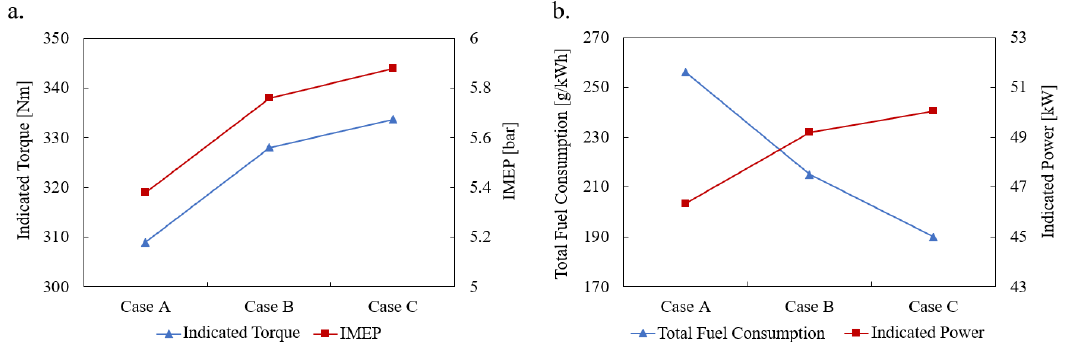
Figure 17. Comparison of performance parameters for different cases ( a ) indicated torque and IMEP, ( b ) total fuel consumption and indicated power.